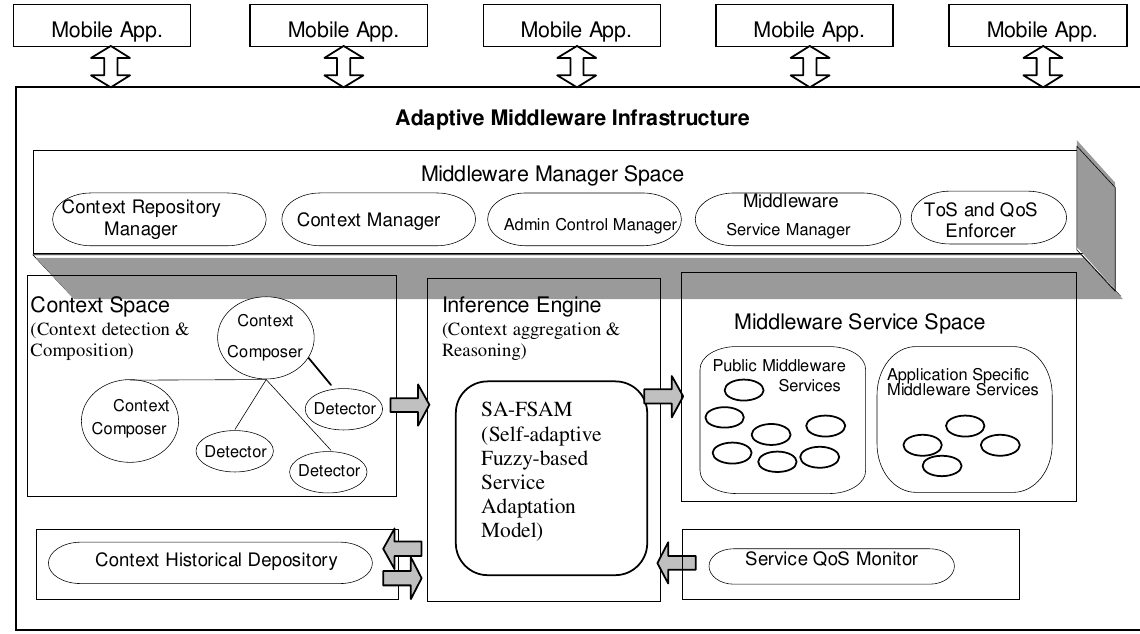
Fig. 2. Adaptive Middleware Infrastructure with Self-Adaptive Fuzzy-based Service Adaptation